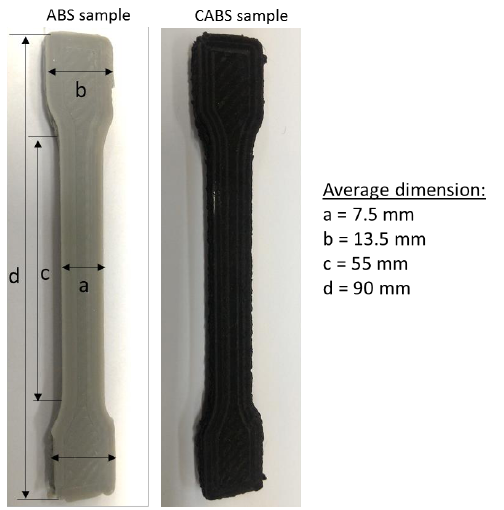
Figure 1. ABS and CABS samples.